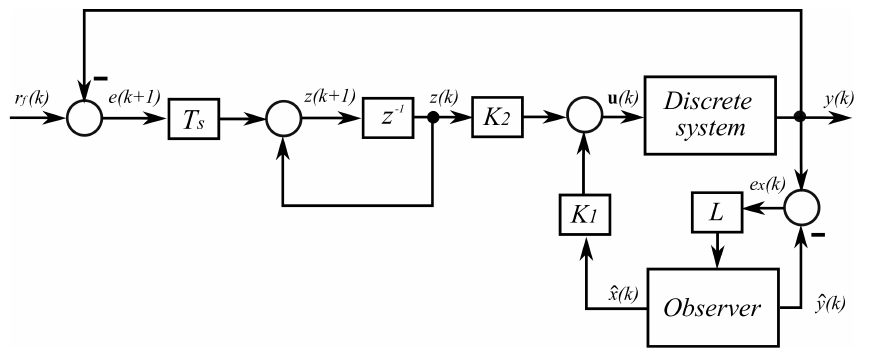
Figure 10. Discrete state variable feedback controller scheme applied to the PSA